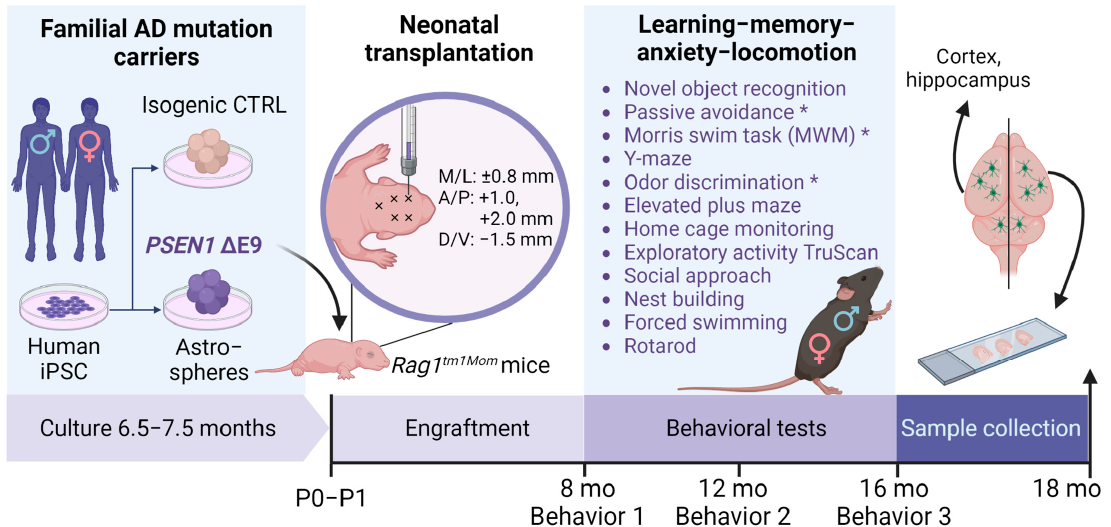
Figure 1. A schematic representation of the experimental setup, created with BioRender.com. PSEN1 ∆ E9 iPSCs obtained by reprogramming the patient-derived fibroblasts and isogenic CTRL iPSCs were differentiated into glial progenitors using the astrosphere method. Glial progenitor cells from 6.5–7.5 months-old astrospheres were dissociated and injected intraventricularly into newborn mouse pups. The mice then underwent a battery of behavioral tests at the ages of 8, 12, and 16 months. Brain samples were collected at the age of 18 months. Behavioral tests marked with * were performed only once at the age of 16 months. (The figure is created with BioRender.com; accessed on 16 December 2022)